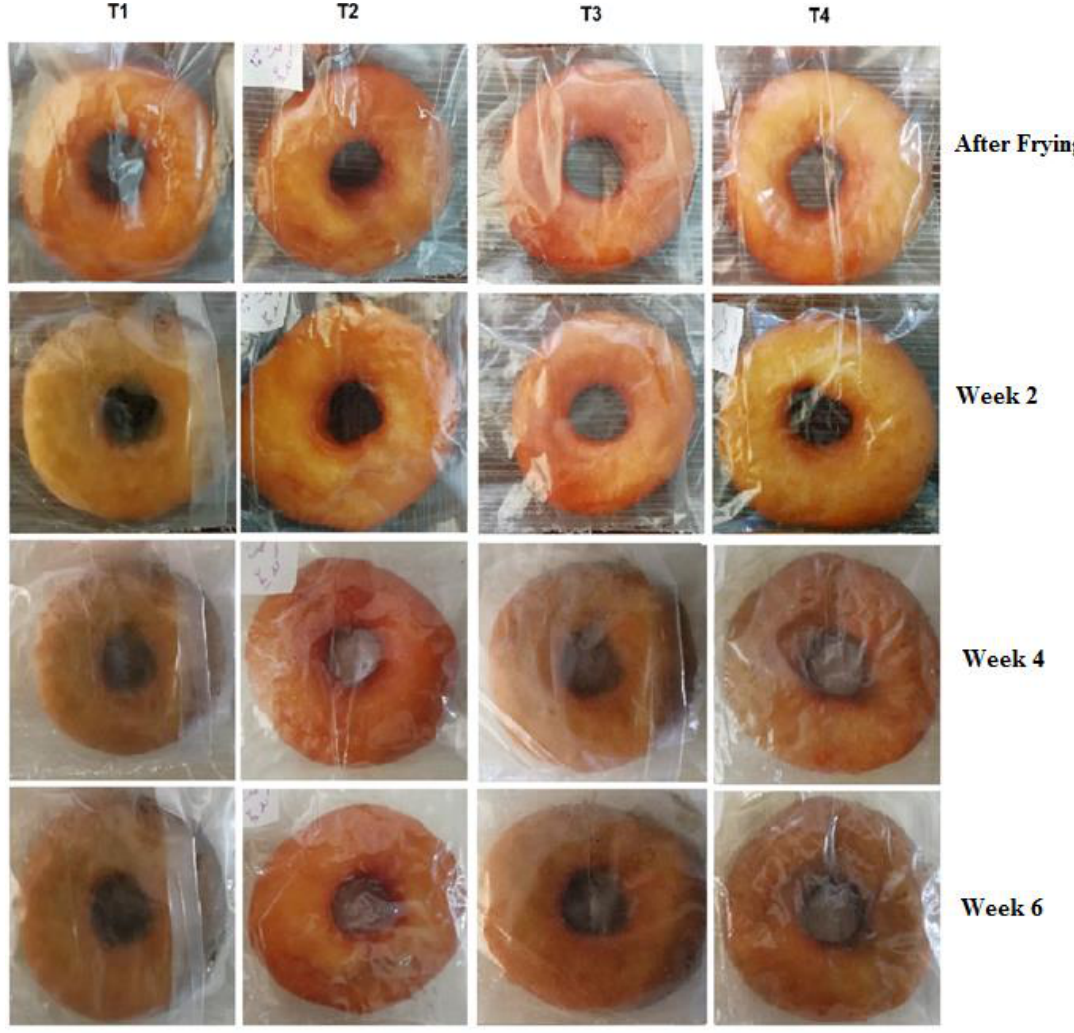
Figure 4. Effect of composition of polypropylene-based films on fungal growth during storage time of packaged donuts.